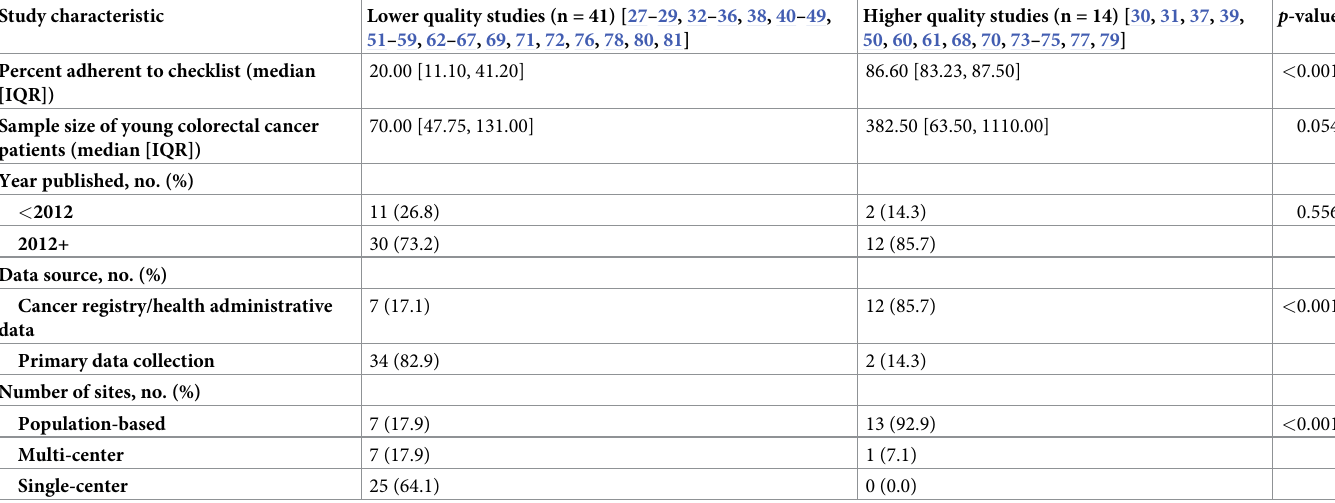
Table 2. Characteristics of higher-quality studies according to the Aarhus